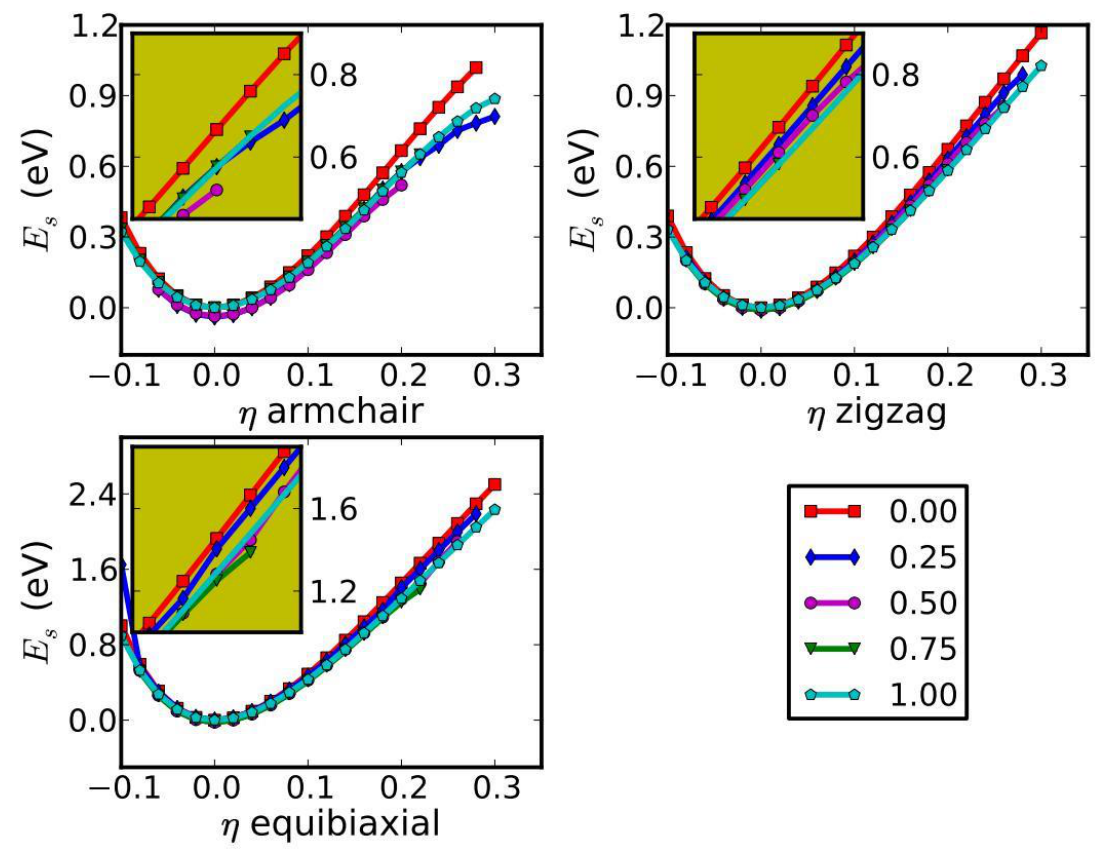
Figure 3. Energy–strain responses for uniaxial strain in armchair and zigzag directions, and equibiaxial strains as a function of g -BN concentrations.